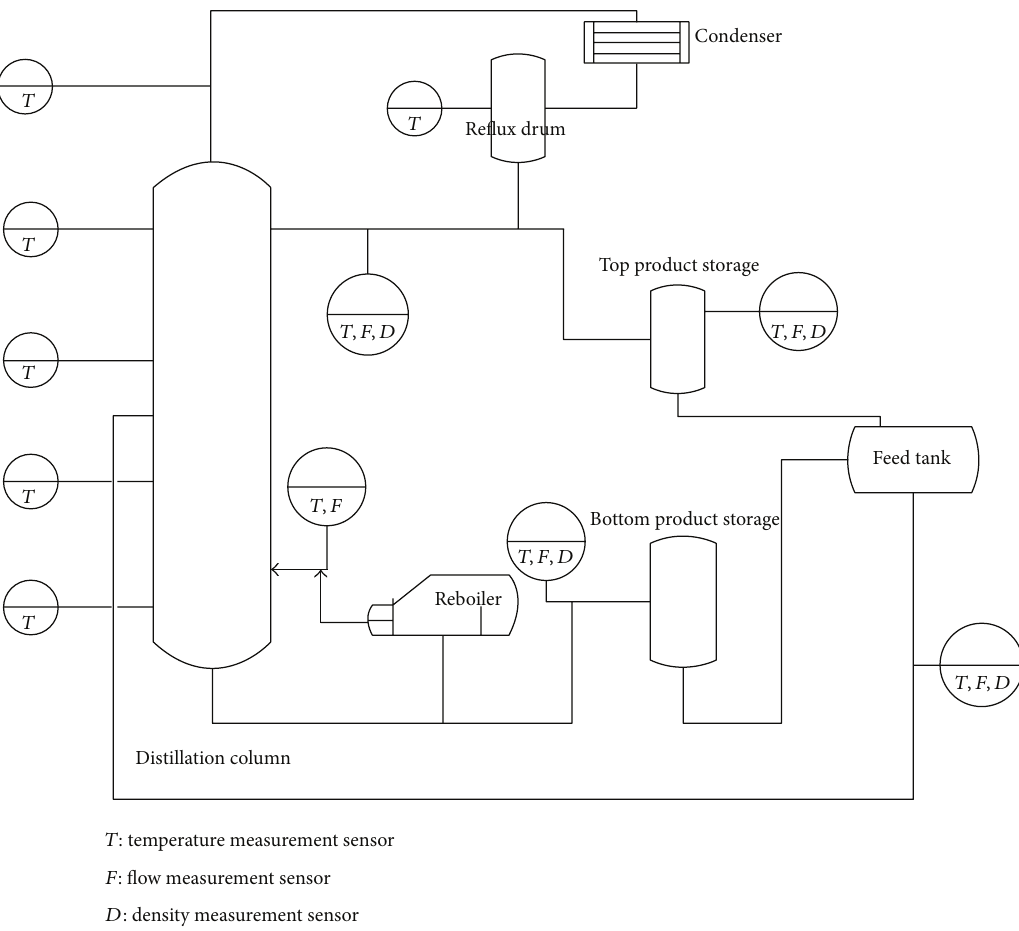
Figure 8: A schematic diagram of the packed bed distillation column setup.